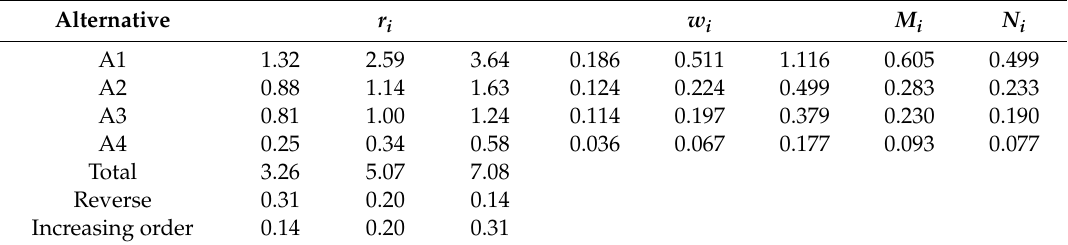
Table 12. Results of r i , W i , M i and N i in respect to the risk criteria.